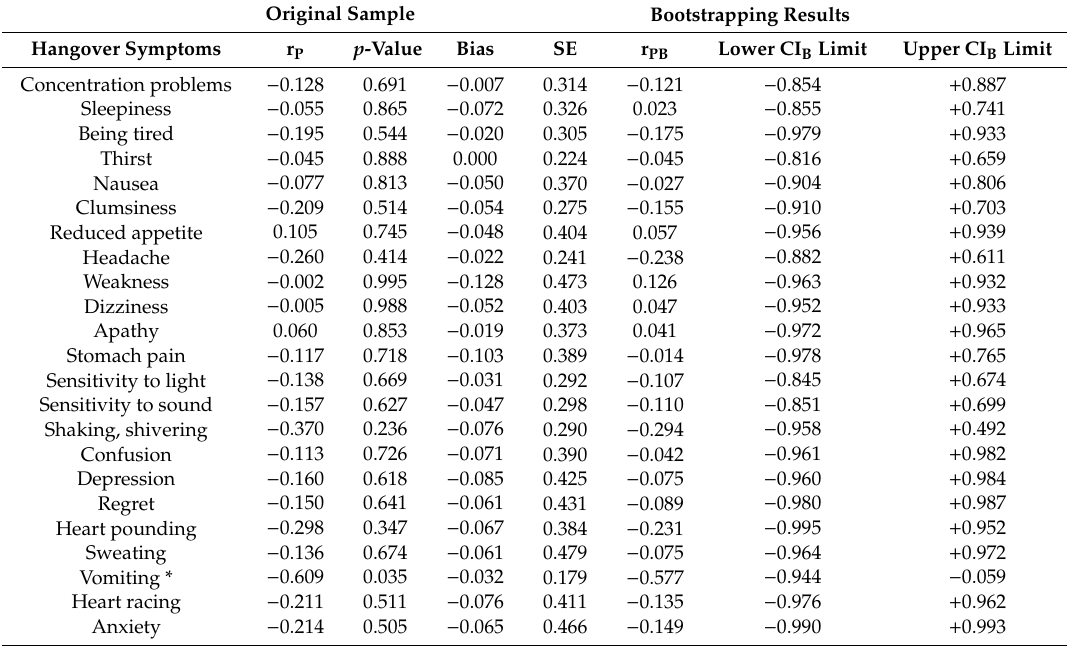
Table 4. Association between dietary zinc intake (two-day average) and hangover symptom